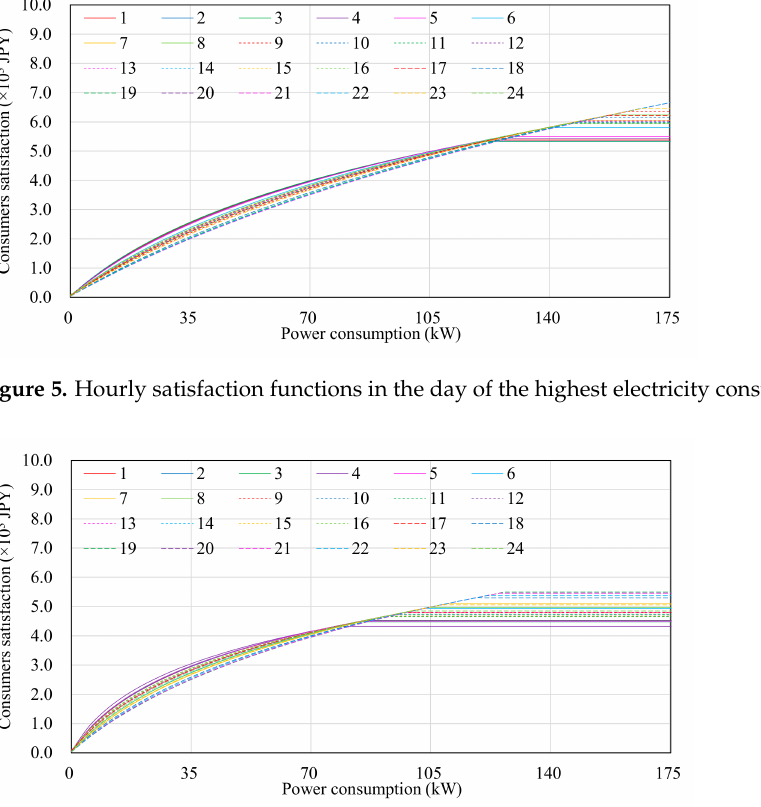
Figure 6. Hourly satisfaction functions in the day of the lowest electricity